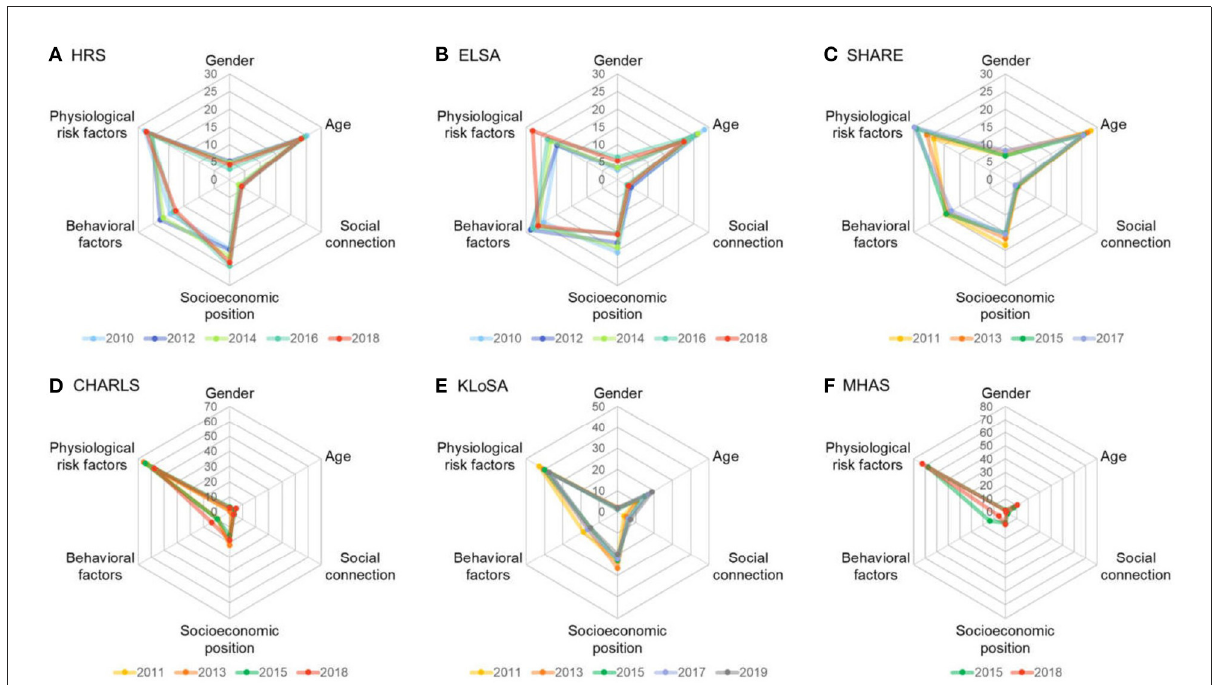
FIGURE1 Contributions of the cardiovascular disease determinants by cohort. Data are presented as standardized dominance statistic (%). HRS, Health and Retirement Study; ELSA, English Longitudinal Study of Aging; SHARE, Survey of Health, Aging and Retirement in Europe; KLoSA, Korean Longitudinal Study of Aging; CHARLS, China Health and Retirement Longitudinal Study; MHAS, Mexican Health and Aging